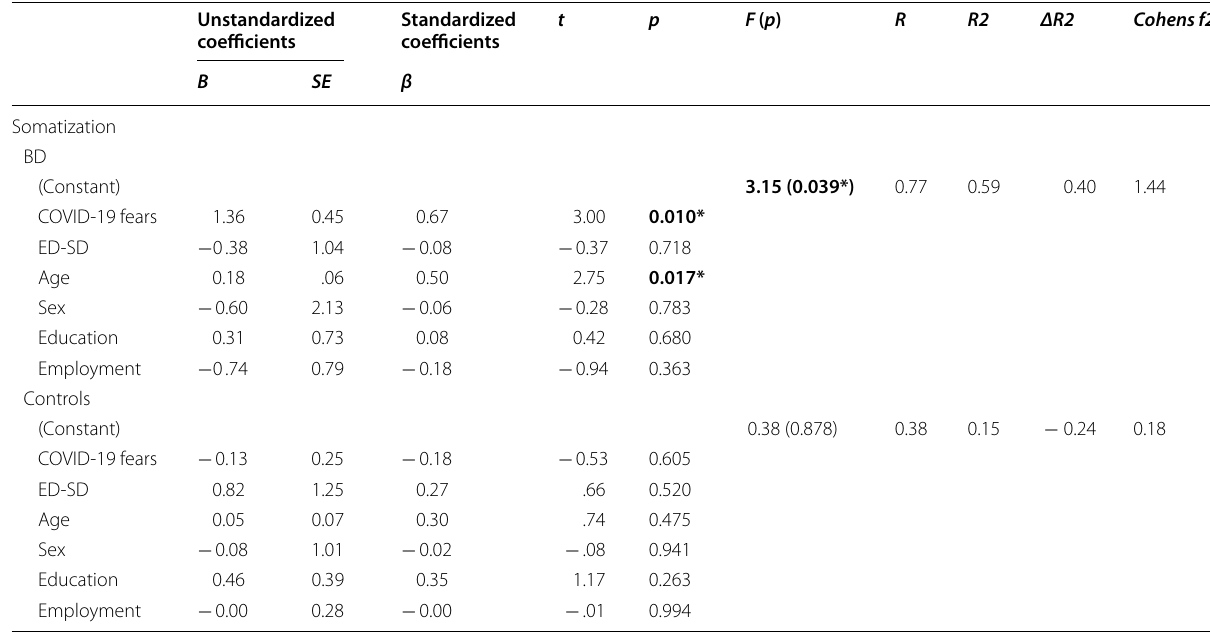
BD bipolar disorder, ED-SD emotional distress due to social distancing * p < 0.05 in bold; multiple linear regression results on somatization with COVID-19 fears and ED-SD as predictors corrected for age, sex, education, and employment